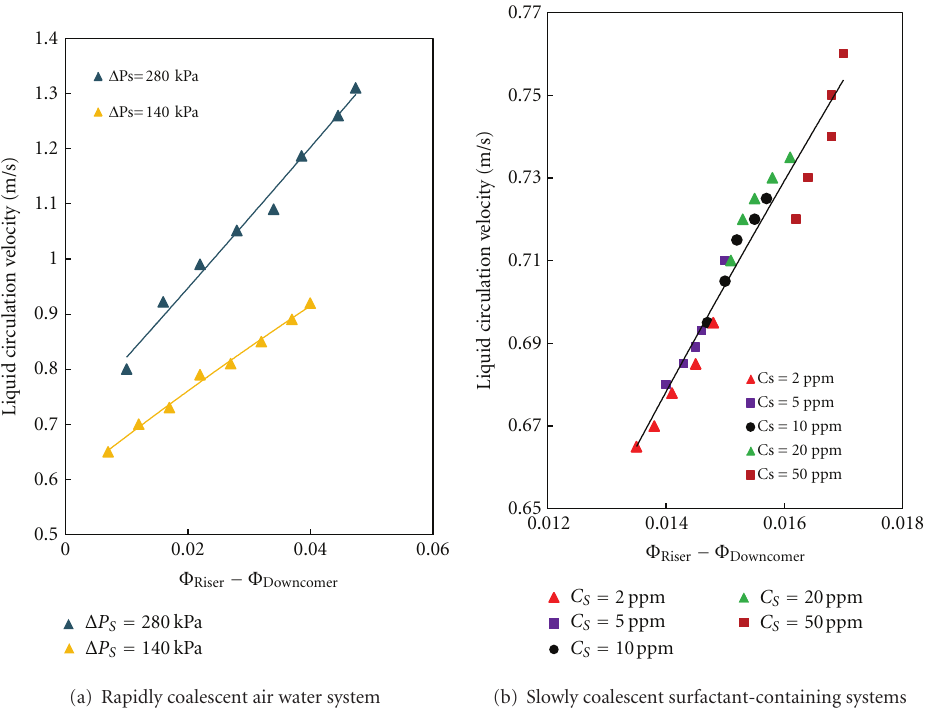
Figure 15: The e ff ect of gas holdup di ff erential (between the riser and downcomer regions) on the liquid circulation velocity ( W L = 0 . 06 kg/s, Δ P = S